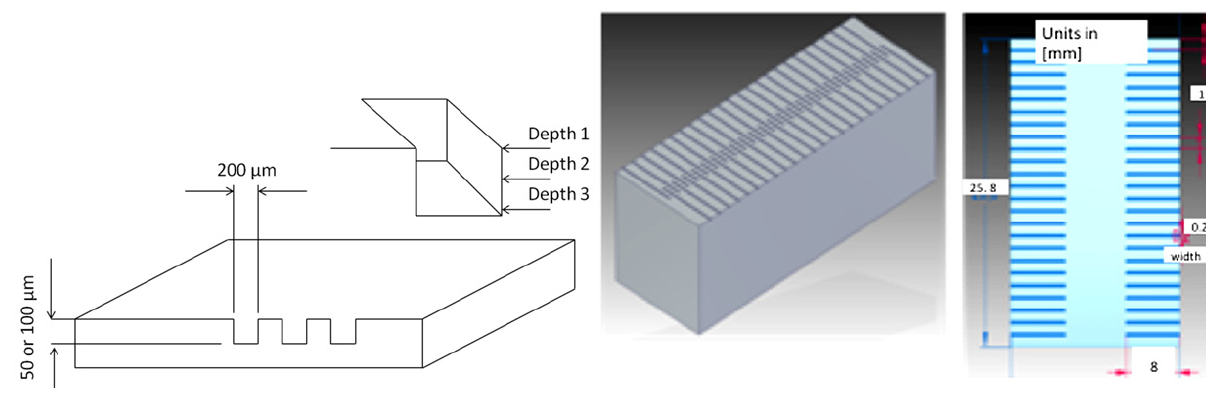
Figure 4. Micro-channel design.